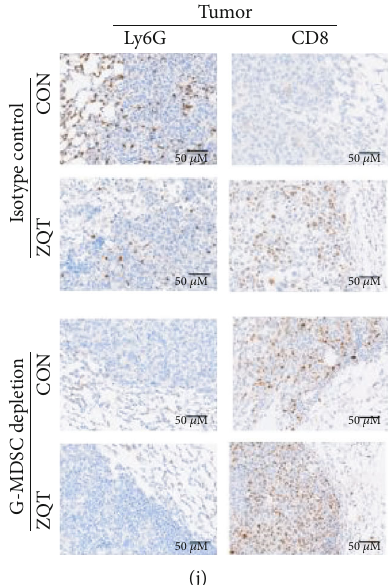
Figure 7: ZQT induced apoptosis in G-MDSCs in TME and inhibited its immunosuppressive activity by activating the STAT3/S100A9/Bcl- 2/caspase-3 signaling pathway. Mice were treated with anti-Ly6G neutralizing antibody or isotype control by intraperitoneal injection for 14 days before surgery, after which model mice were given maintenance treatment every other day. (a, b) The bioluminescence images of model mice on day 7 and day 28 after surgery. (c) Survival curves. (d, e) The percentage of G-MDSCs, CD3 + T cells, CD4 + T cells, and CD8 + T cells in tumor tissue were analyzed by fl ow cytometry. (f, g) CD3 + T cells isolated from the tumor tissue of tumor-bearing C57BL/6 mice in di ff erent groups were cocultured with LLC cells for 4 h before they were incubated with CD3, CD8, and CD107 α antibodies. Events shown were fi nally gated on CD3 and CD8. (h) ELISA analysis for the expression of IFN- γ in cells from tumor tissue. (i) RT-qPCR analysis of Arg-1, iNOS, and S100A9 gene expression and fl ow cytometry for ROS production. (j) IHC staining for Ly6G and CD8 in tumor tissue (scale bar: 50 μ M). n = 5 . Data are expressed as the mean ± SD . n/s: nonstatistical signi fi cance. ∗ p < 0 : 05 ; ∗∗ p < 0 : 01 ; ∗∗∗ p < 0 : 001